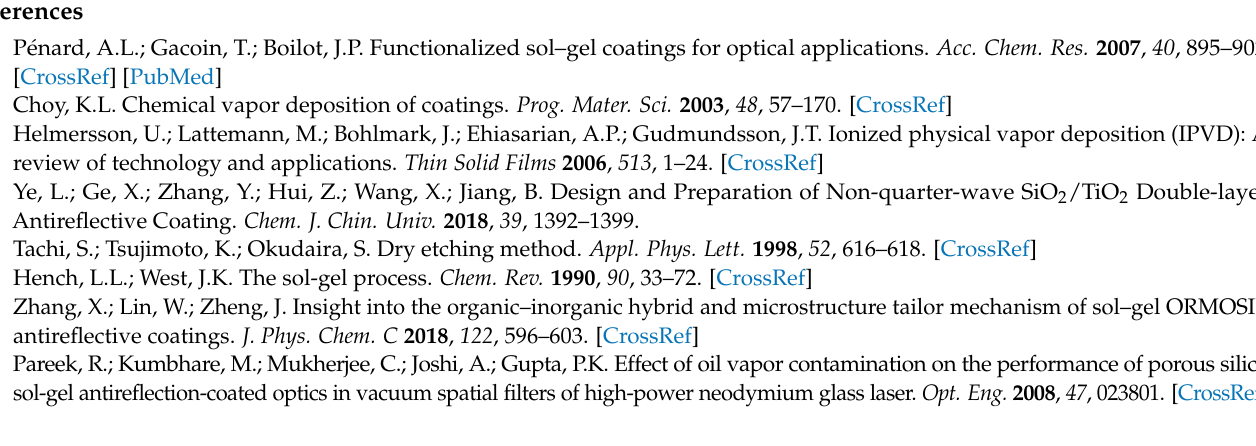
Figure 11. Transmittance spectrum of ( a ) untreated double-layer film and the film after being exposed in humid environment; ( b ) transmittance spectra of treated film after exposing to humid environment.